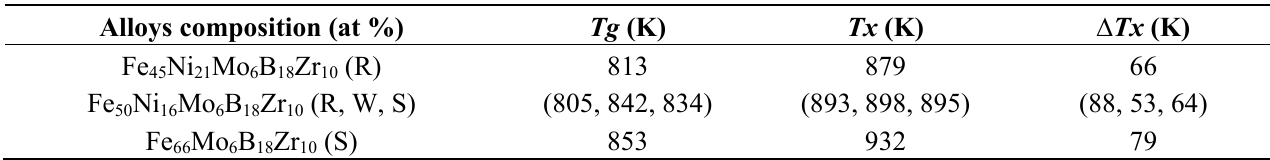
Ni Mo B Zr amorphous m n 6 18 10